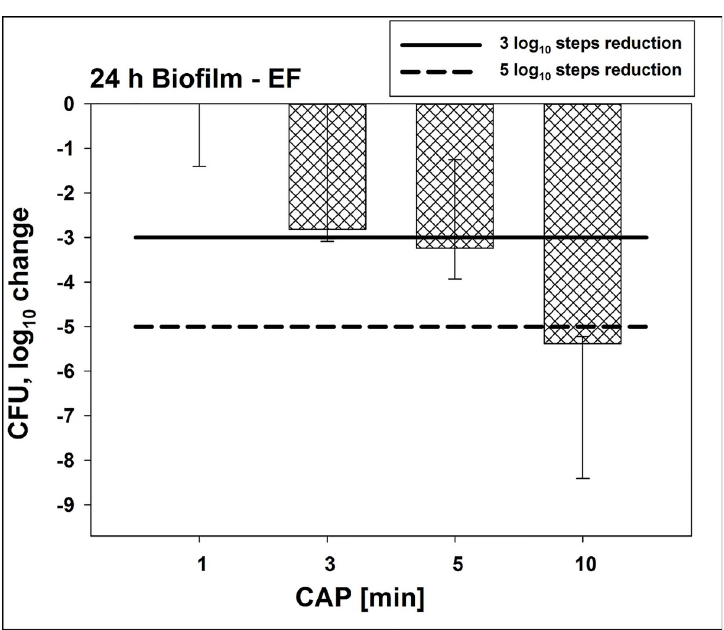
Fig 3. Antimicrobial efficacy of CAP towards E . faecalis biofilms cultured for 24 h. CAP was performed for different treatment periods towards biofilms cultured for 24 h. All results are depicted as medians, 1 st and 3 rd quartiles from six independent experiments in duplicates on a log 10 -scaled ordinate. Bars show the reductions of CFU in a log 10 scale in comparison to untreated controls. Solid and dashed lines exhibit 3 log 10 steps (99.9%) or 5 log 10 reduction (99.999%) of CFU, respectively. ( n = 6; untreated controls exhibited 7.3 x 10 10 CFU in median).